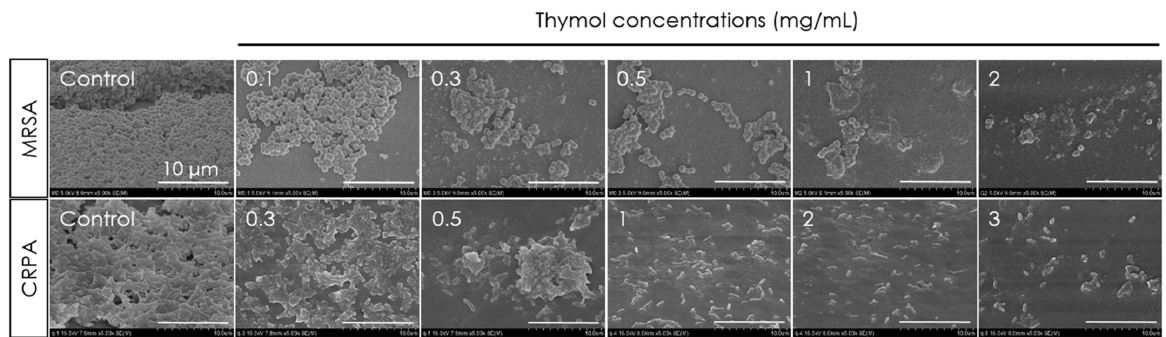
Figure 6. Scanning electron micrographs of methicillin-resistant Staphylococcus aureus (MRSA) and ciprofloxacin-resistant Pseudomonas aeruginosa (CRPA) biofilms on the surface of